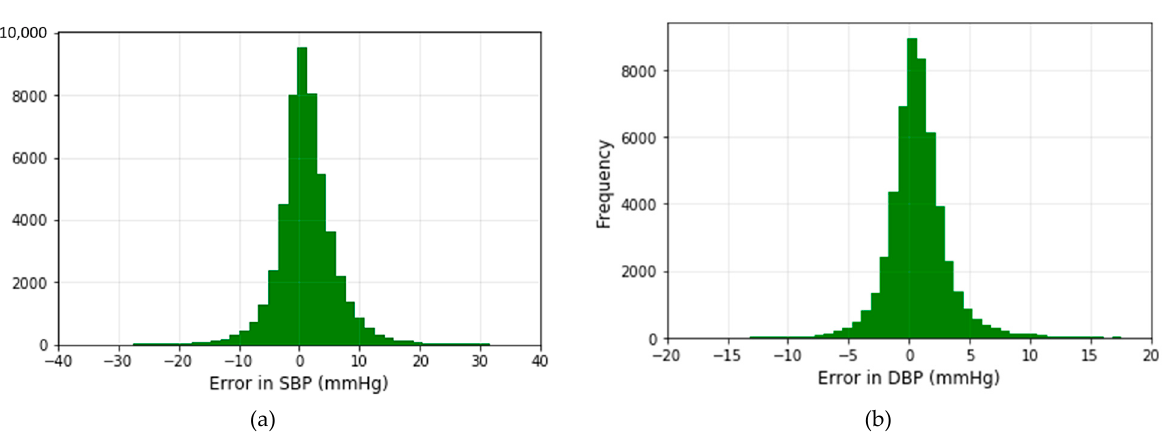
Table 2. Performance summary of proposed U-net Model on test dataset for SBP, DBP, and mean